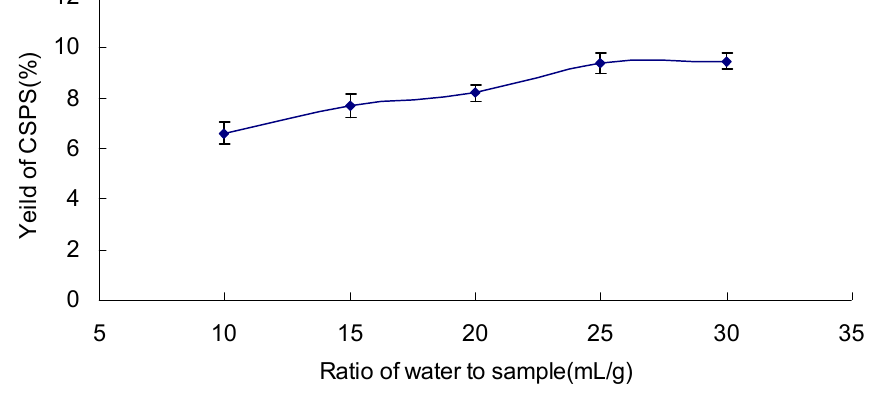
Figure 3. Effect of ratio of water to sample on the yield of CSPS under extraction temperature 90 °C, extraction time120 min, and extraction cycle